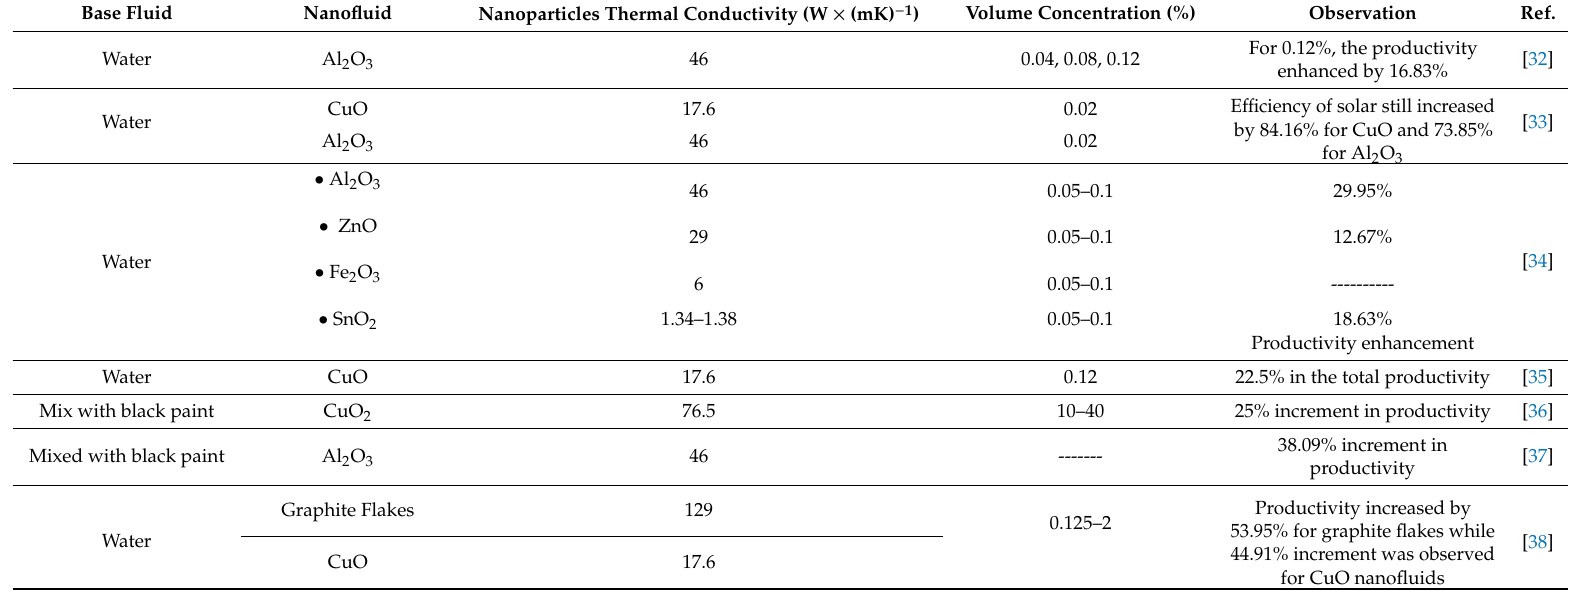
Table 5. Review of nanofluids in solar still